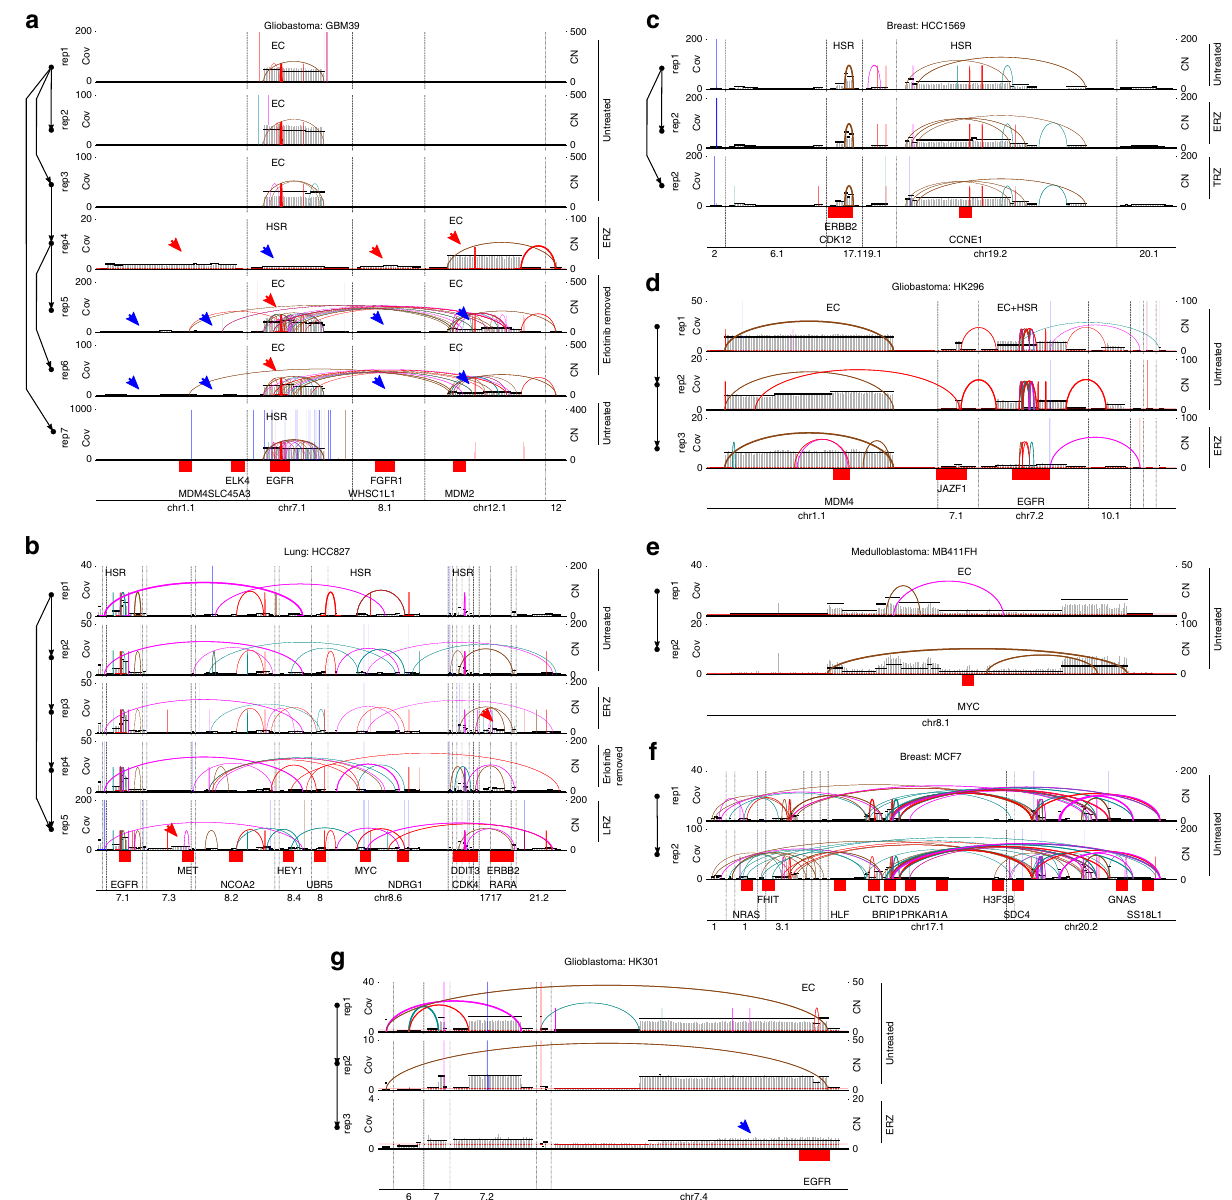
Fig. 3 AmpliconArchitect (AA) amplicons evolving over time or in response to drug treatment: a GBM39: patient-derived xenograft (PDX), glioblastoma; b HCC827: Cell-line, lung; c HCC1569: Cell-line, breast; d HK296: Cell-line, glioblastoma; e MB411FH: Cell-line, medulloblastoma; f MCF7: Cell-line, breast; g HK301: Cell-line, GBM. For each sample, one row per replicate shows a combined structural variant (SV) view of all amplicons including intervals ampli fi ed in other biological replicates of that sample. The left axis shows replicate ID and passage of cell line or PDX, whereas right axis shows the condition of the replicate: Untreated, undergoing drug treatment or after drug removal; ERZ: erlotinib resistant; LRZ: lapatinib resistant; TRZ: trastuzumab resistant. Within each replicate, known locations of oncogenes, EC (ecDNA), HSR or EC + HSR, as determined by FISH, are indicated in the corresponding replicate row. Red and blue arrows, respectively, indicate a gain and loss in copy number or formation of new amplicons with respect to parent cell line or 49% (33) of all samples (Fig. 4a, fi gshare, Supplementary Data 8).